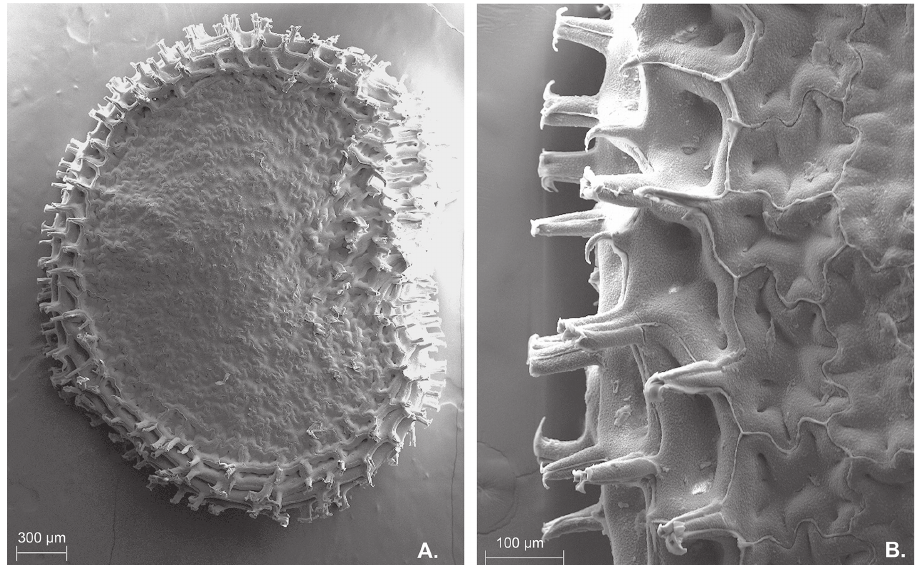
Figure 3. Seed of C. regale Barboza & Bohs viewed under SEM. A Seed B Seed coat sculpture. From Orejuela et al. 3034